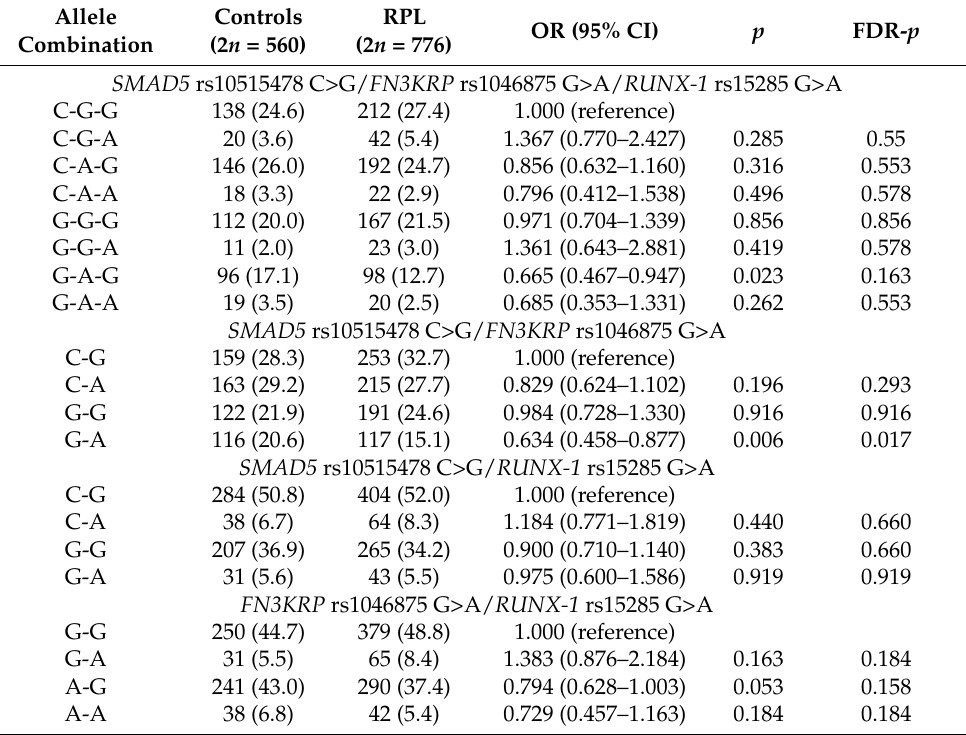
Table 3. Haplotype analysis of gene polymorphisms in control and RPL groups.